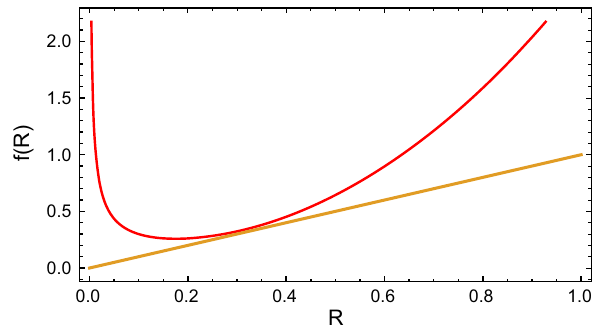
Fig. 4 Numerical solution of f = f ( R ) with R being the independent variable.Wetake a 0 = 1(inreducedPlanckunit), n = 1 / 3and k γ = 1. The straight line is a plot of the Ricci scalar